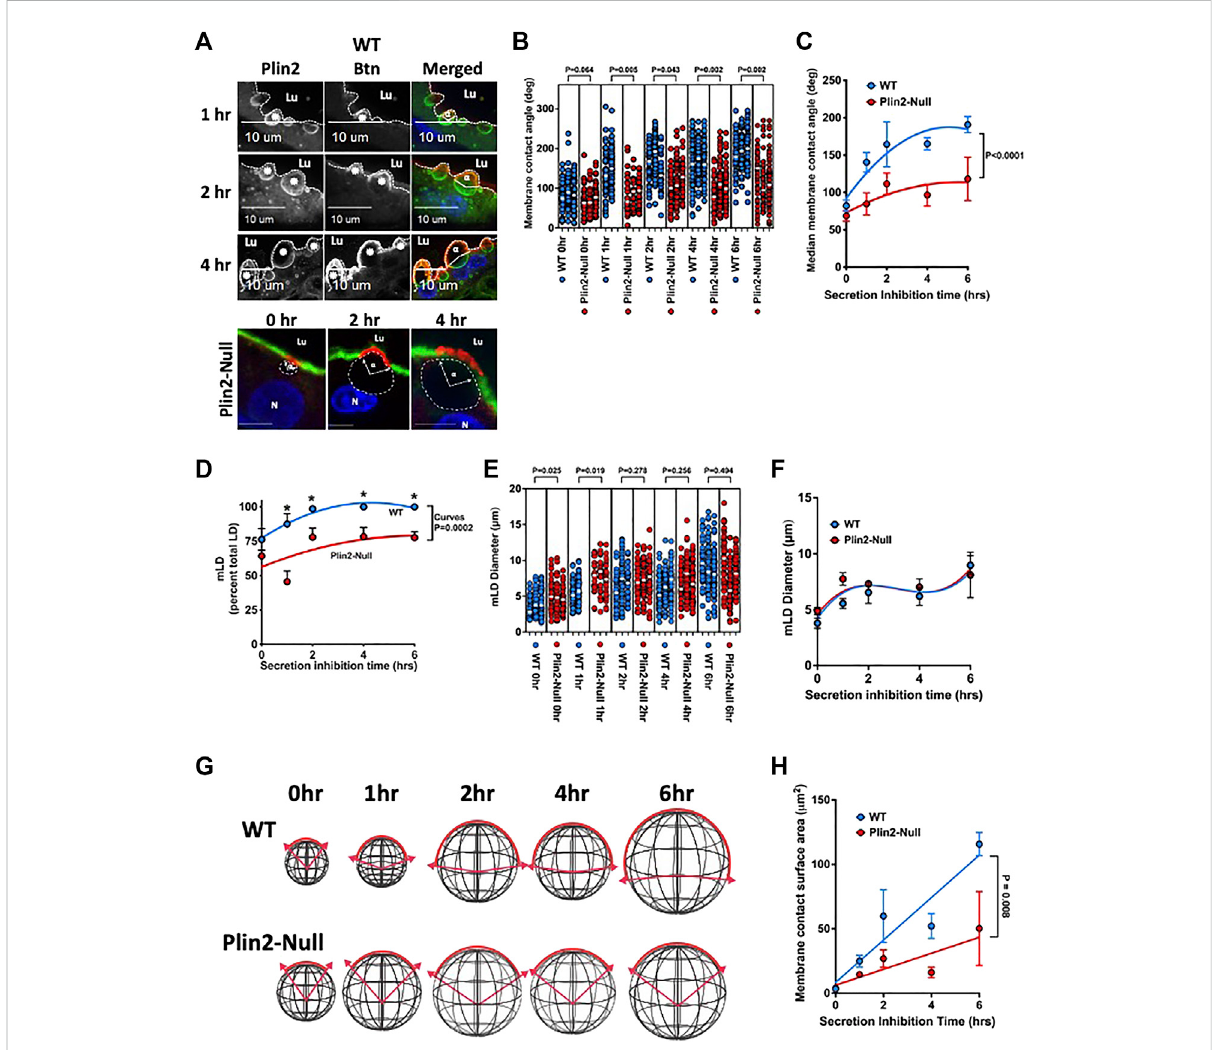
FIGURE 2 LD-APM envelopment. (A) Immuno fl uorescence images showing time-dependent expansion of LD-APM contacts following the inhibition of apocrine lipid secretion in sMEC from WT and Plin2-NULL mammary glands. Sections from WT cells immunostained for Plin2 (green in merged panels) and BTN (red in merged panels) to identify LD (asterisks) and LD-APM contacts respectively. LD-APM contact angles ( α ) are indicated in merged panels. Apical borders are indicated by the dotted line, luminal space is labeled (Lu) and scale bars are indicated. Sections from Plin2- NullglandswerestainedforBTN(red)andAlexa488-labledWGAtoidentifyLD-APMcontactsitesandapicalbordersrespectively.LDintheseimages werelocalizedbyauto fl uorescenceandoutlinedbydashedlines.LD-APMcontactangles( α ),luminalspace(Lu)andnuclei(N)arelabeled.Scalebars are10 µm. (B) ChangesinLD-APMcontactanglesinWTandPlin2-NullsMECfollowingsecretioninhibition. LD-APMcontactangleswerequanti fi ed insMECfrom20 – 40randomlyselectedmammaryalveolifrom3WTandPlin2-Nulldamsateachtimepoint,except1hinwhichmeasurementswere from 2 WT to 3 Plin2-Null dams. White bars indicate median membrane contact angles. p values for group differences were determined by nested t -testand areshown above eachcomparison. (C) Curvesdescribingchangesinmedian LD-APM contact angles following inhibition weregenerated using centered second order polynomial least-squares- fi t (Prism 9.3.1). Values are means ± SEM (N = 3, 60 – 80 alveoli/dam). p value correspondsto differences between curves determined by extra sum-of-squares F test. (D) The percentage of LD contacting the APM (mLD) following secretion inhibition in WT and Plin2-Null dams. Curves were generated using centered second order polynomial least-squares- fi t (Prism 9.3.1). Values are averages ±SEM (N = 3, 60 – 80 alveoli/dam). p value corresponds to differences between curves determined by extra sum-of-squares F test. (E) Effects of inhibiting secretion on mLD diameters from WT and Plin2-Null dams. mLD diameters were quanti fi ed in sMEC from 20 – 40 randomly selected mammary alveoli from 3 WT and Plin2-Null dams at each time point. White bars indicate median values. p values for group differences at each time point were determined by nested t -test and are shown above each comparison. (F) Curves describing effects of secretion inhibition time onmediandiametersofmLDweregenerated usingcentered thirdorder polynomial least-squares- fi t(Prism 9.3.1). Valuesareaverages±SEM(N=3, 60 – 80 alveoli/dam). (G) Diagrams depicting how measured changes in LD diameters and LD-APM contact angles are projected to affect the extent LD-APMengagementinWTandPlin2-Nulldamsat0,1,2,4,or6 hafterinhibitingsecretion. (H) ChangeincalculatedmembraneareacontactingLD in WT and Plin2-Null dams as a function of time after inhibiting secretion. Curves were generated using linear least-squares- fi t. p -values refer to differences in the slopes of the curves determined by extra sum-of-squares F